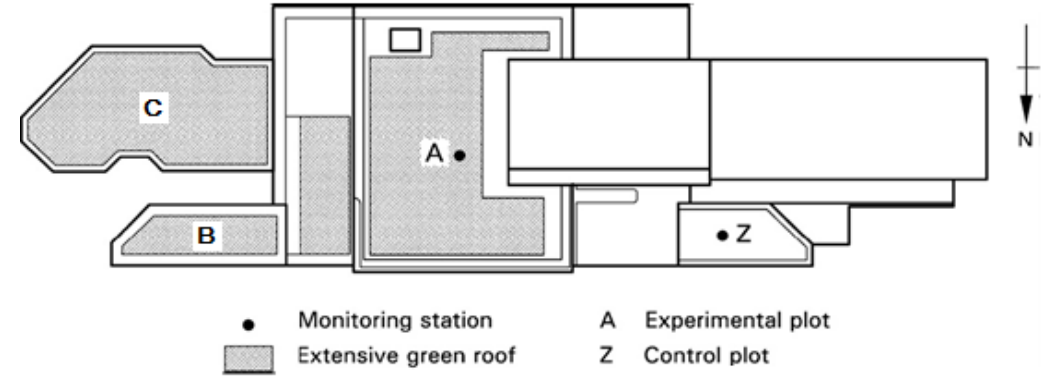
Figure 2. Layout of the experimental green-roof